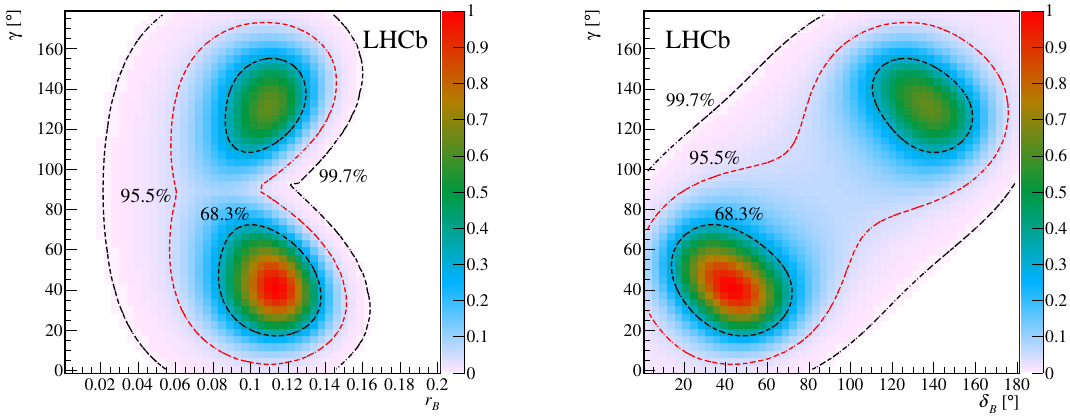
Figure 4. Contour plots showing 2D scans of physics parameters (cid:13) versus r B (left) and (cid:13) versus (cid:14) B (right). The dashed lines represent the (cid:1) (cid:31) 2 = 2 : 30 ; 6 : 18 ; 11 : 8 contours, corresponding to 68.3%, 95.5%, 99.7% con(cid:12)dence levels (CL), respectively. The colour scale represents 1 (cid:0)